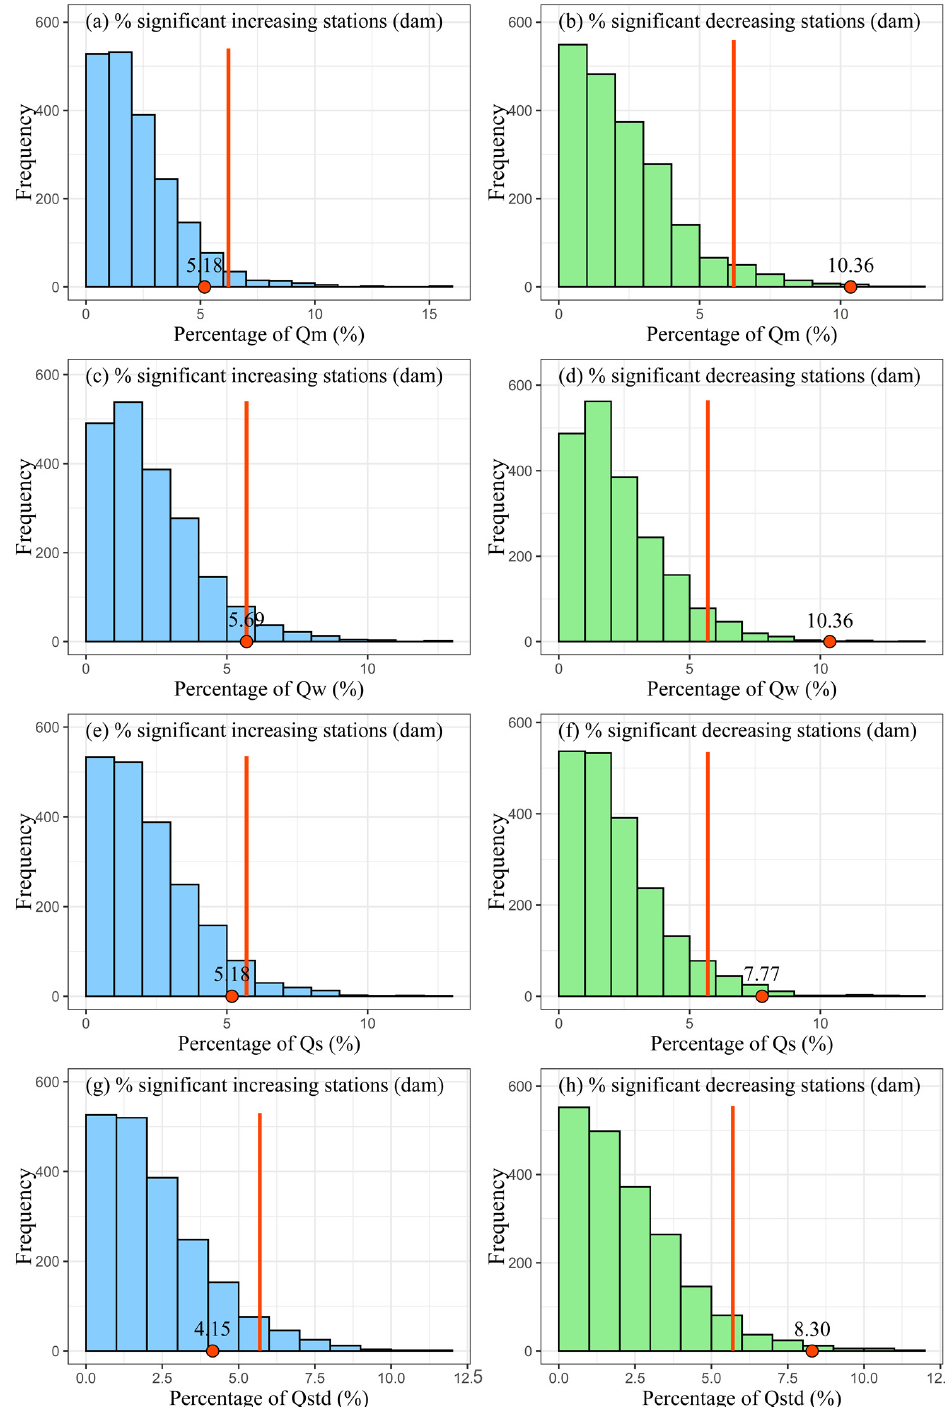
Figure 8. The same as Figure 7, but for the four runoff signatures, i.e., ( a , b ) Qm, ( c , d ) Qw, ( e , f ) Qs, ( g , h ) Qstd. For high flow signature (Q99), the percentages of stations showing SDT are more than two times higher than that showing SIT. The proportion of stations with a SDT and SIT accounts for 8.29% and 3.63%, respectively. Similar results can be found in mean flow signatures (Qm and Qw) and flow dynamic signature (Qstd). Their percentages of stations showing a SDT are approximately twice as much as those showing a SIT. In particular, the percentages of stations showing a SDT reach 10.36%, 10.36%, and 8.30%, respectively, while the percentages of stations with a SIT are 5.18%, 5.69%, and 4.15%. Q99, Qm, Qw, and